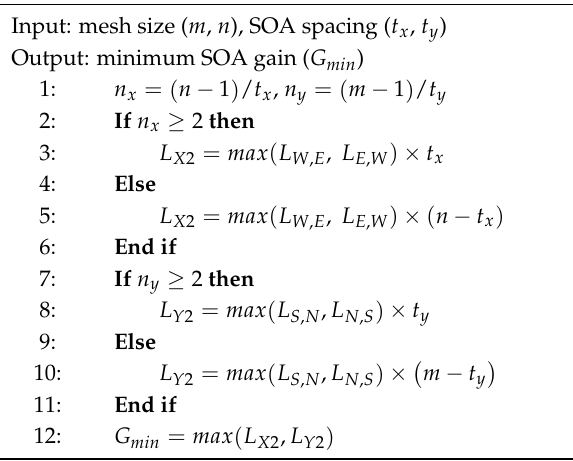
Algorithm 2. Calculation for the Minimum SOA